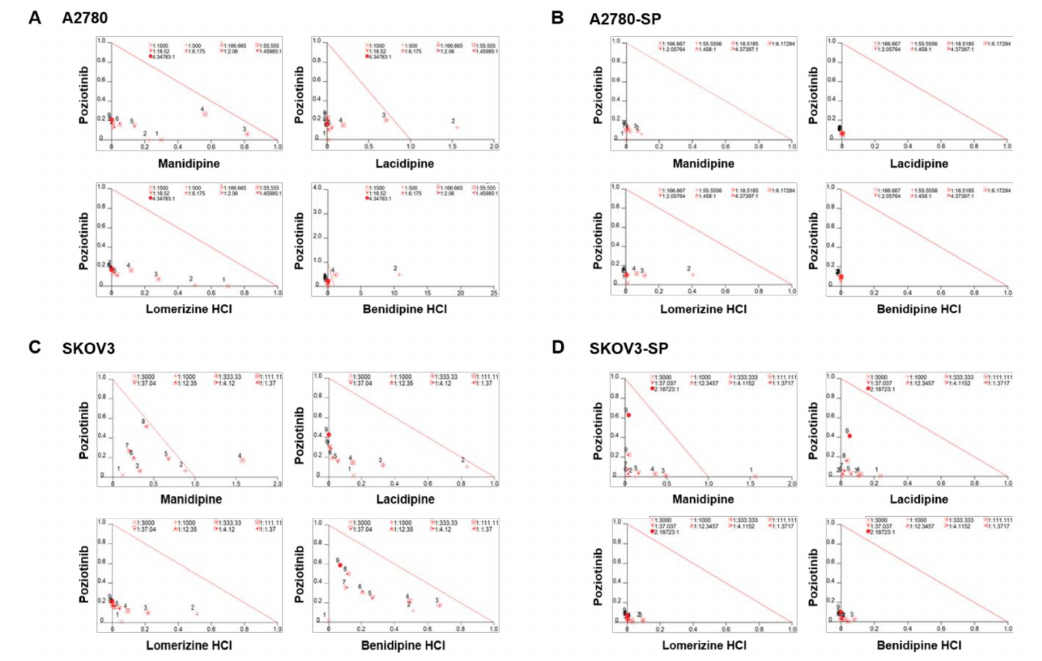
Figure 2. Isobolograms of poziotinib and calcium channel blocker (CCB) combination therapy for ovarian cancer cells and ovarian cancer stem cells (CSCs). ( A – D ) Normalized isobolograms of combination therapy with poziotinib and CCBs in A2780 cells ( A ), A2780-SP cells ( B ), SKOV3 cells ( C ), and SKOV3-SP cells ( D ). The data were analyzed using CalcuSyn software. The solid line represents additivity. Data points below the line indicate a synergistic interaction, and data points above the line indicate an antagonistic interaction. The numbers under the isobolograms indicate the concentrations of the drugs.